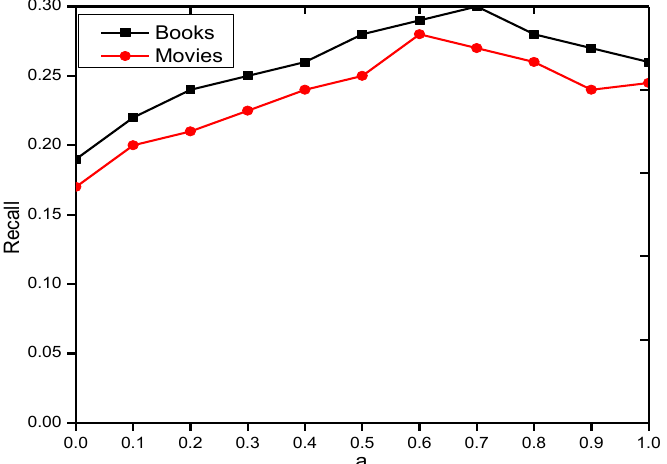
Figure A8. Performance of D-GDL against the comparative approaches based on Recall vs. M for Flixster dataset in the dense setting.